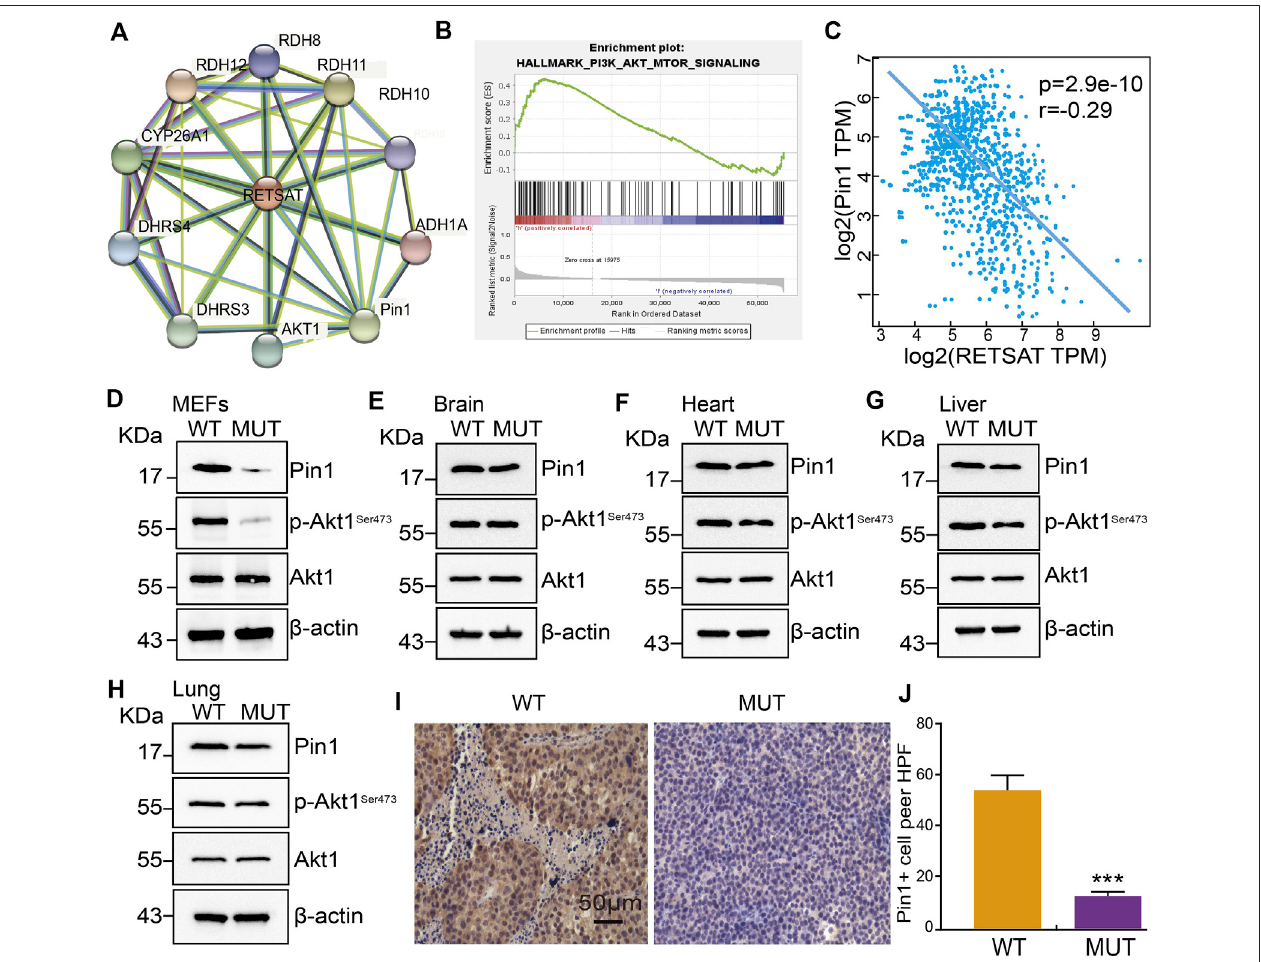
FIGURE 6 | RETSAT (Q247R) mutation represses Pin1 related signaling pathway. (A) The protein interaction network of RETSAT was generated using STRING database. (B) Enrichment plots from GSEA showing the PI3K/Akt signaling pathway associated with RETSAT expression in SKCM. (C) The spearman correlation analysis revealed a correlation between RETSAT and Pin1 expression in TCGA-SKCM database. (D – H) Examining the relative protein expressions by immunoblot in MEFs (D) , Brain (E) , Heart (F) , Liver (G) and Lung (H) isolated from of wild-type and mutant mice, respectively. (I – J) Representative IHC staining of PIN1 for indicated xenograft tumors after RETSAT mutation. * p < 0.05, ** p < 0.01, *** p < 0.001.